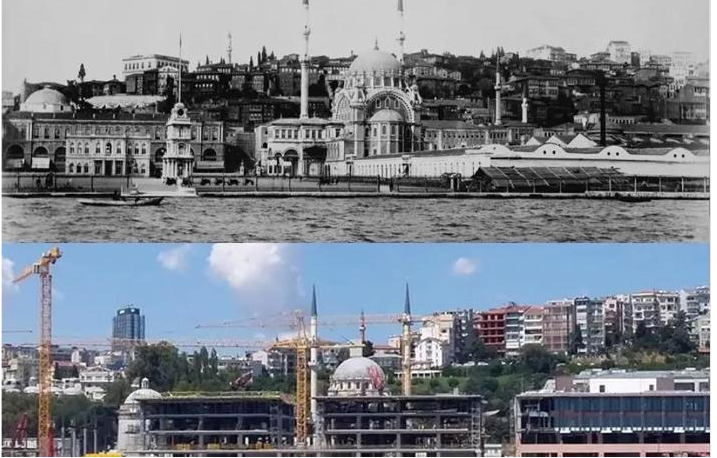
Figure 11 Impact of the project from the coastal area to the silhouette, the 1900s (top) and 2020 (bottom) (Url,